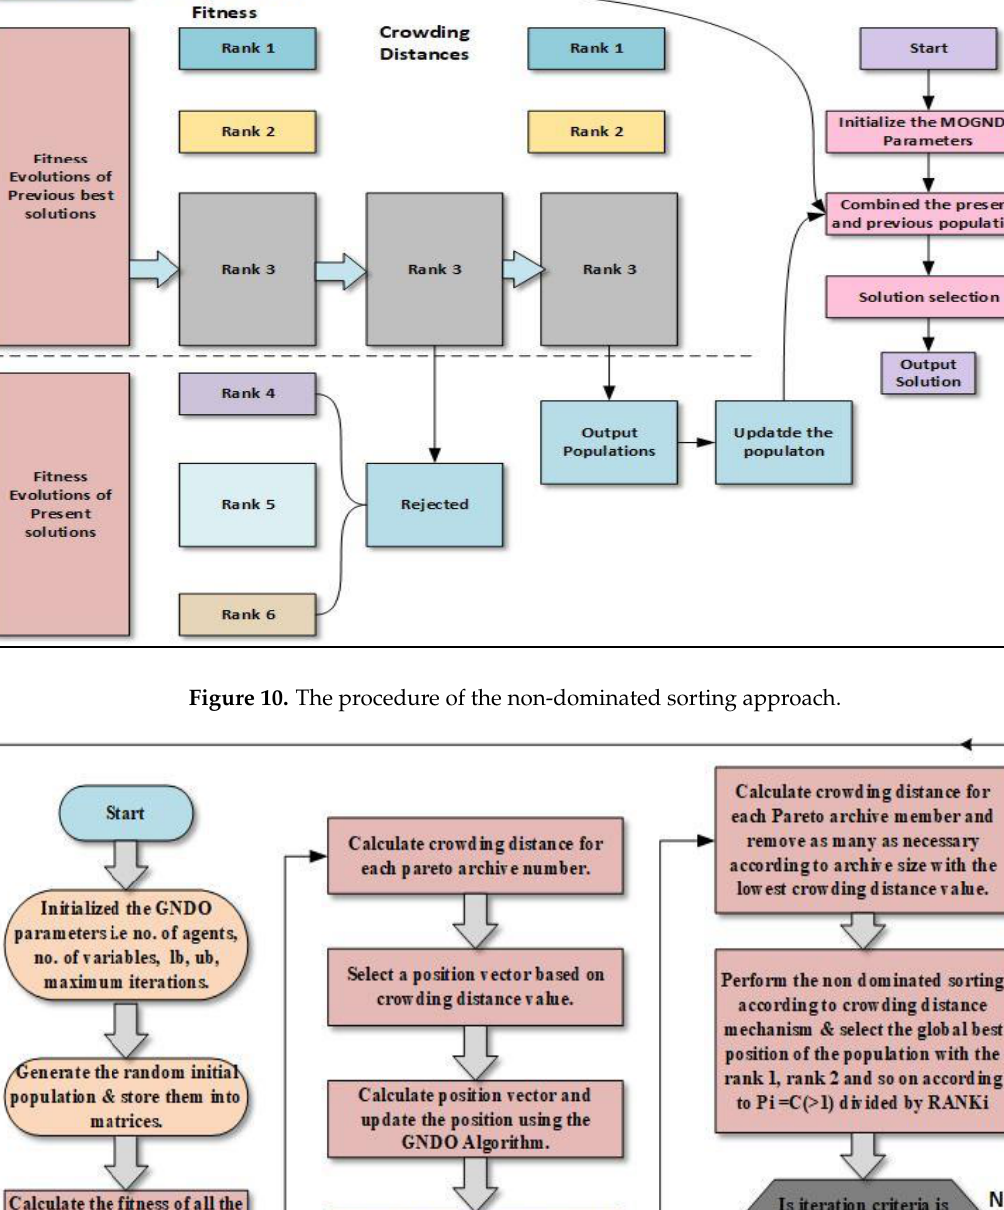
Algorithm 1: Pseudocode of Multi-objective Generalized Normal Distribution Opti-